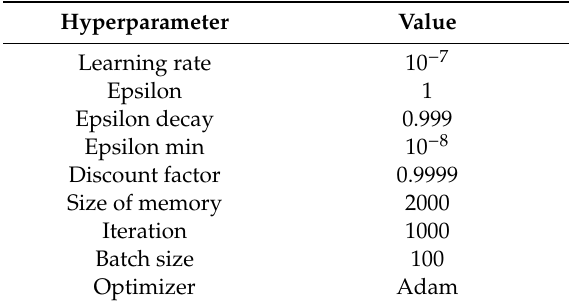
Table 3. Hyperparameters.